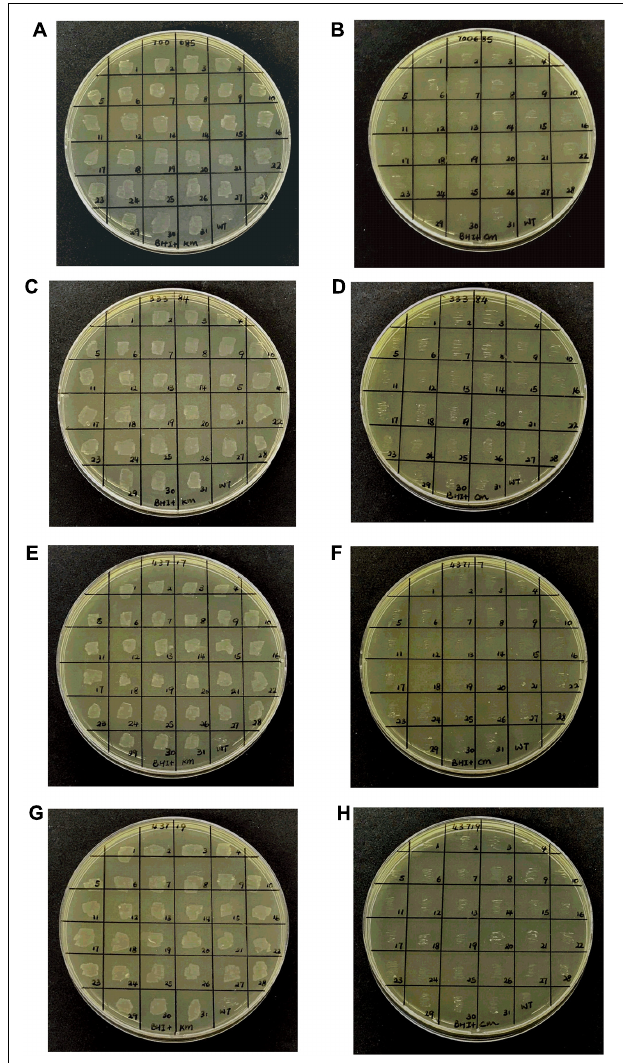
FIGURE 2 | Resistance of Aggregatibacter actinomycetemcomitans transconjugants. Random transconjugants ( n = 31) were selected and inoculated on either BHI agar supplemented with kanamycin (A,C,E,G) or chloramphenicol (B,D,F,H) . The resistance of A. actinomycetemcomitans ATCC 700685 (A,B) , 33384 (C,D) , 43717 (E,F) , and 43719 (G,H) wild-type (indicated as WT), and transconjugants to kanamycin and chloramphenicol are shown.